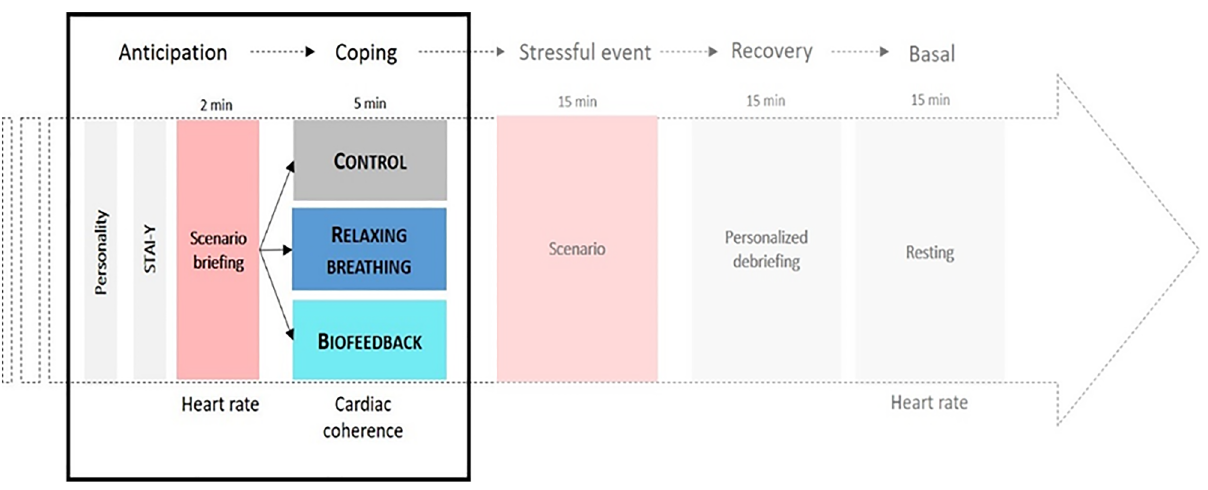
Figure 1. Protocol timeline. STAI-Y: State Anxiety Inventory form